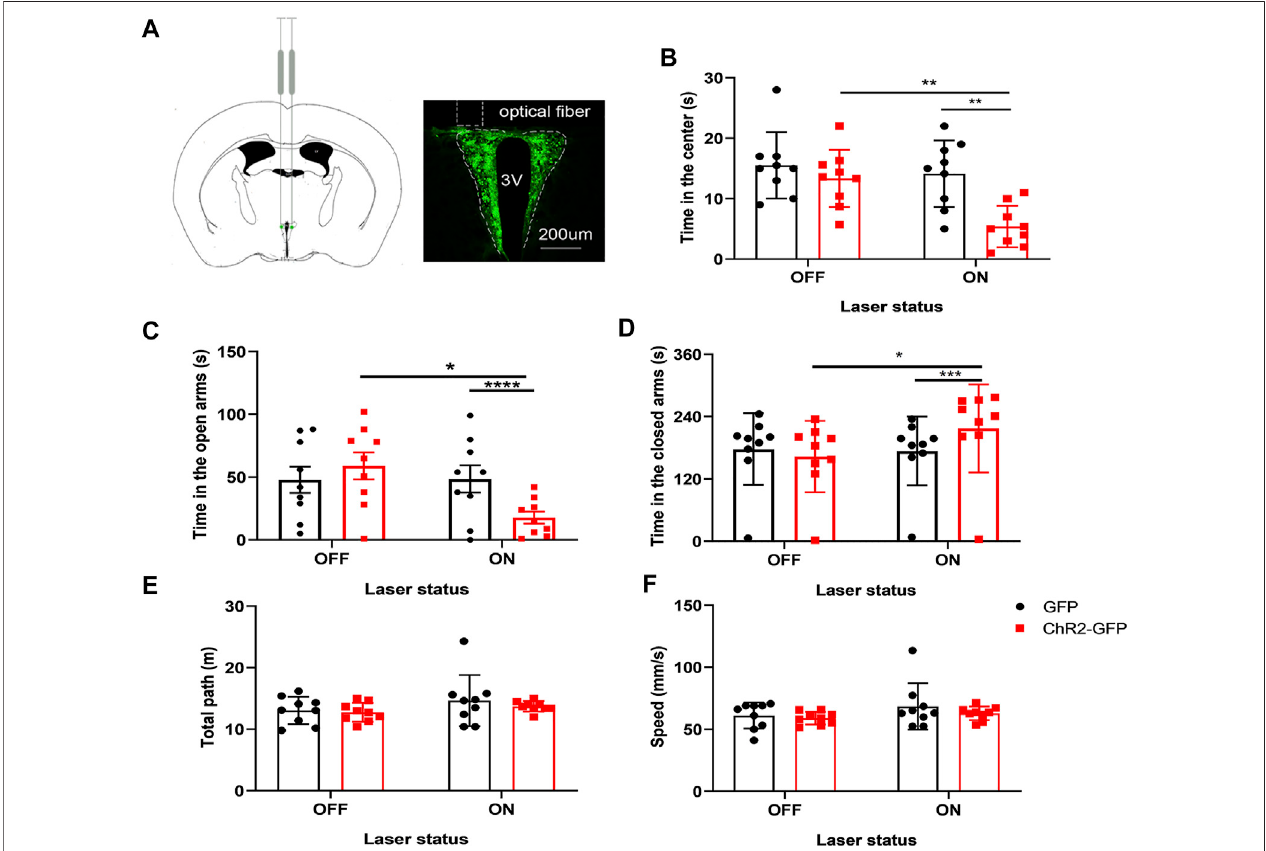
FIGURE2| Optogenetic activation of the PVN glutamatergic neurons increases anxiety-like behaviors in mice. (A) The image showed the expression of the ChR2-GFP virus in PVN. (B) Activation of the PVN glutamatergic neurons decreased the time in the center in the open- fi eld test. (C) Activation of the PVN glutamatergic neurons decreased the open-arms time in the EPM test. (D) Activation of the PVN glutamatergic neurons increased the close-arms time in the EPM test. (E) Activation of the PVN glutamatergic neurons did not affect the moving distance of the mice. (F) Activation of the PVN glutamatergic neurons did not affect the speed of the mice (* p < .05, ** p < .01, *** p < .001, n = 9/group. Error bars denote SEM. Two-way repeated measures ANOVA was performed followed by Bonferroni ’ s post hoc